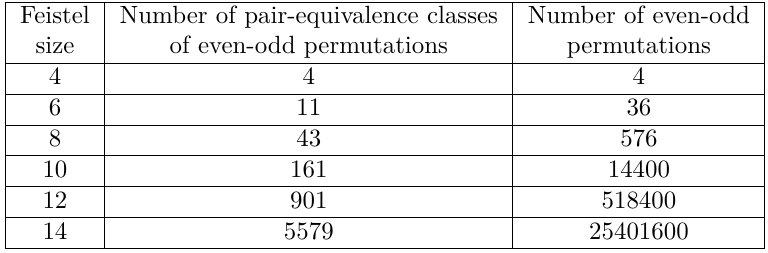
Table 3: Number of pair-equivalence classes of even-odd permutations Feistel Number of pair-equivalence classes Number of even-odd size of even-odd